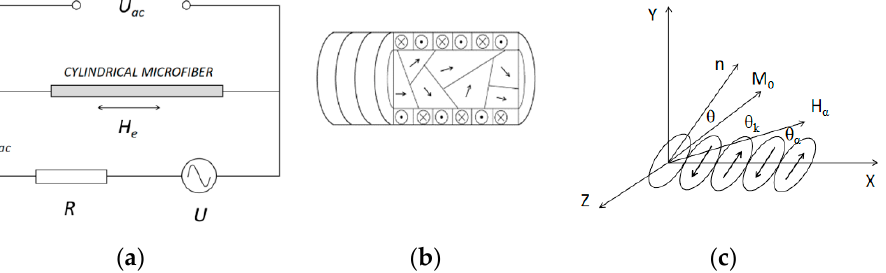
Figure 1. ( a ) The schematic diagram of GMI effect in cylindrical alloy fiber. ( b ) Schematic diagram of the magnetic domain structure. ( c ) Coordinates of cylindrical alloy fiber.